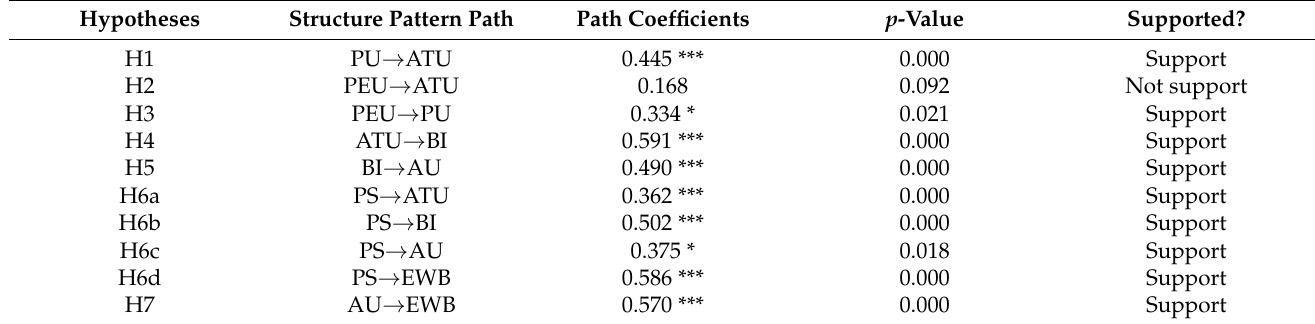
Figure 2. The final model with parameter estimates of the significant paths. * p -value < 0.05, ** p -value < 0.01, and *** p -value < 0.001. Table 4. Path analysis and detection results of the structural